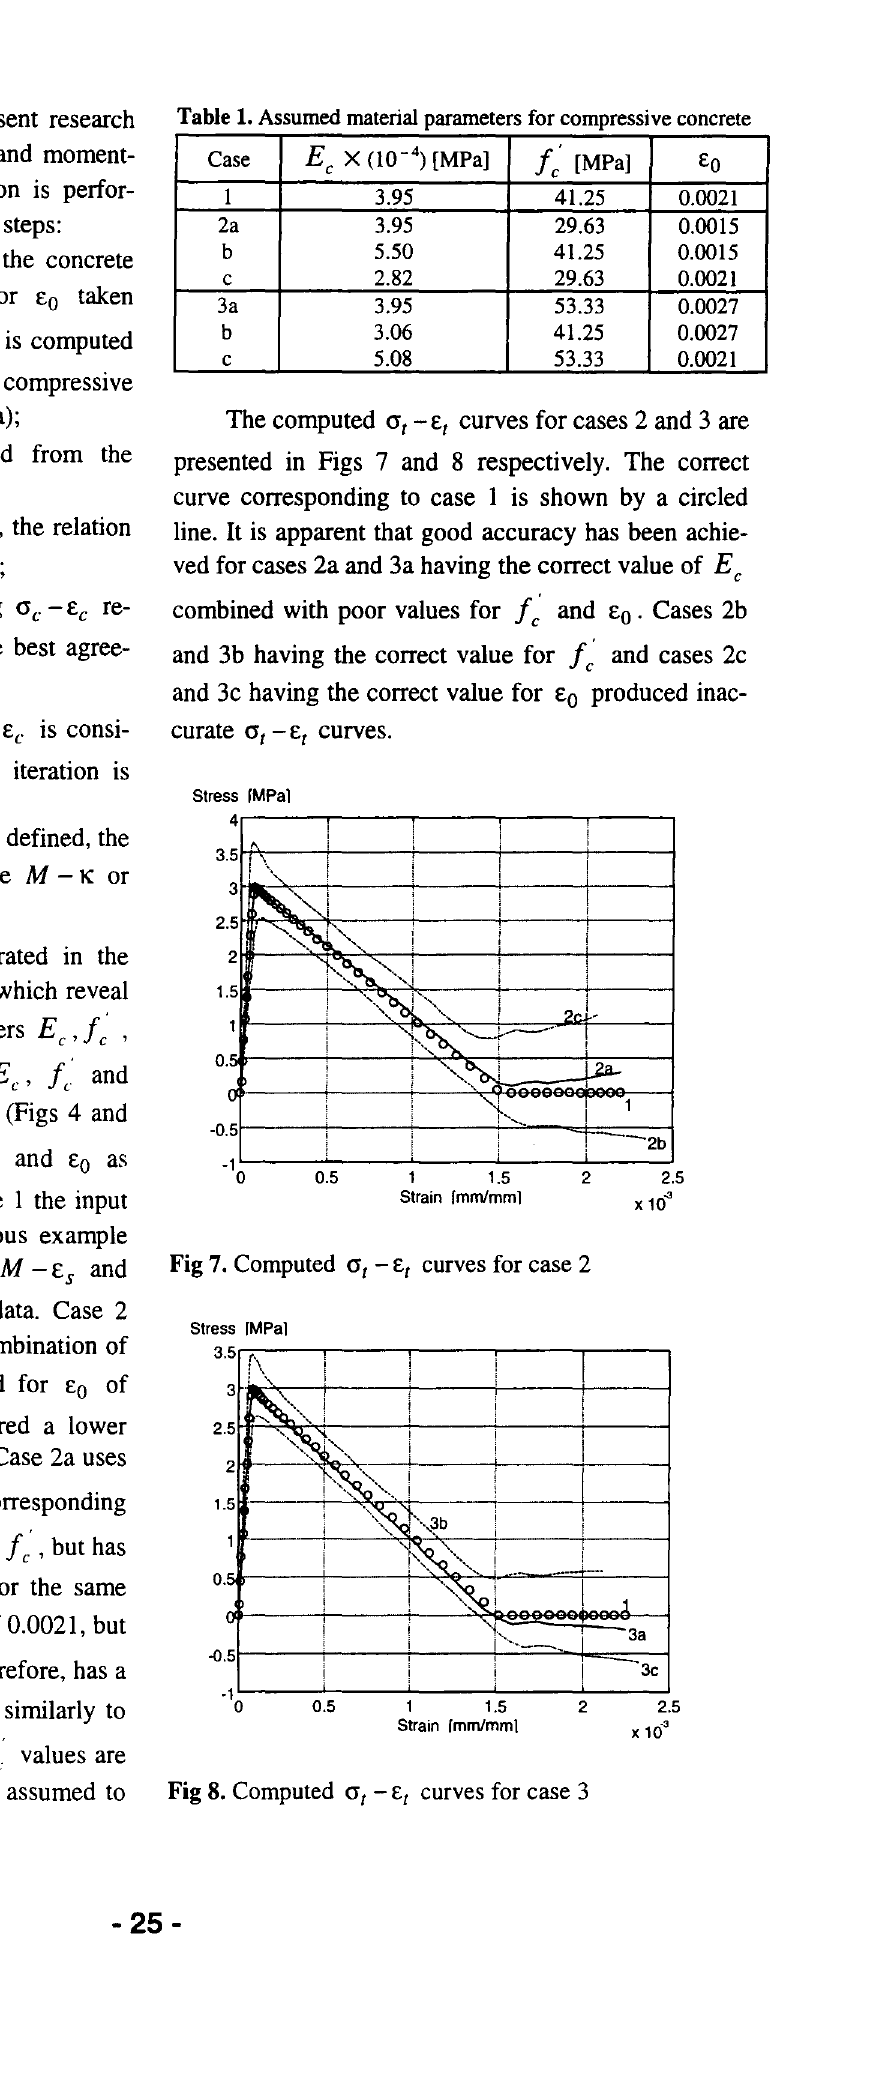
Table 1. Assumed material parameters for compressive concrete